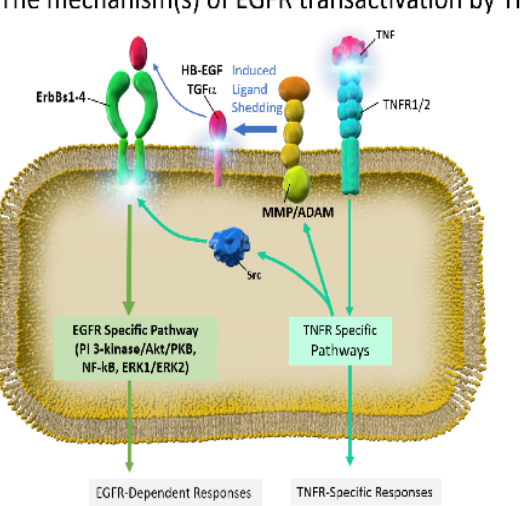
Figure 2. TNF-induced anti-apoptotic cell signaling via tumor necrosis factor receptor (TNFR) to EGFR crosstalk signaling.